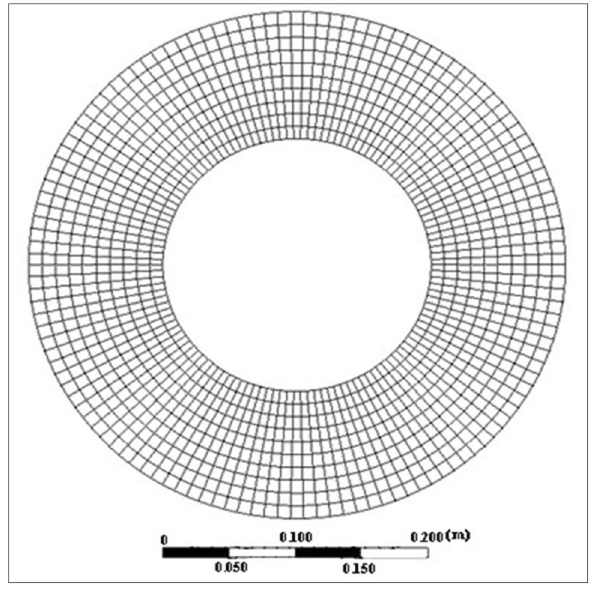
Fig. 4 Transverse cross section of the computational grid created on concentric annulus-drilling string